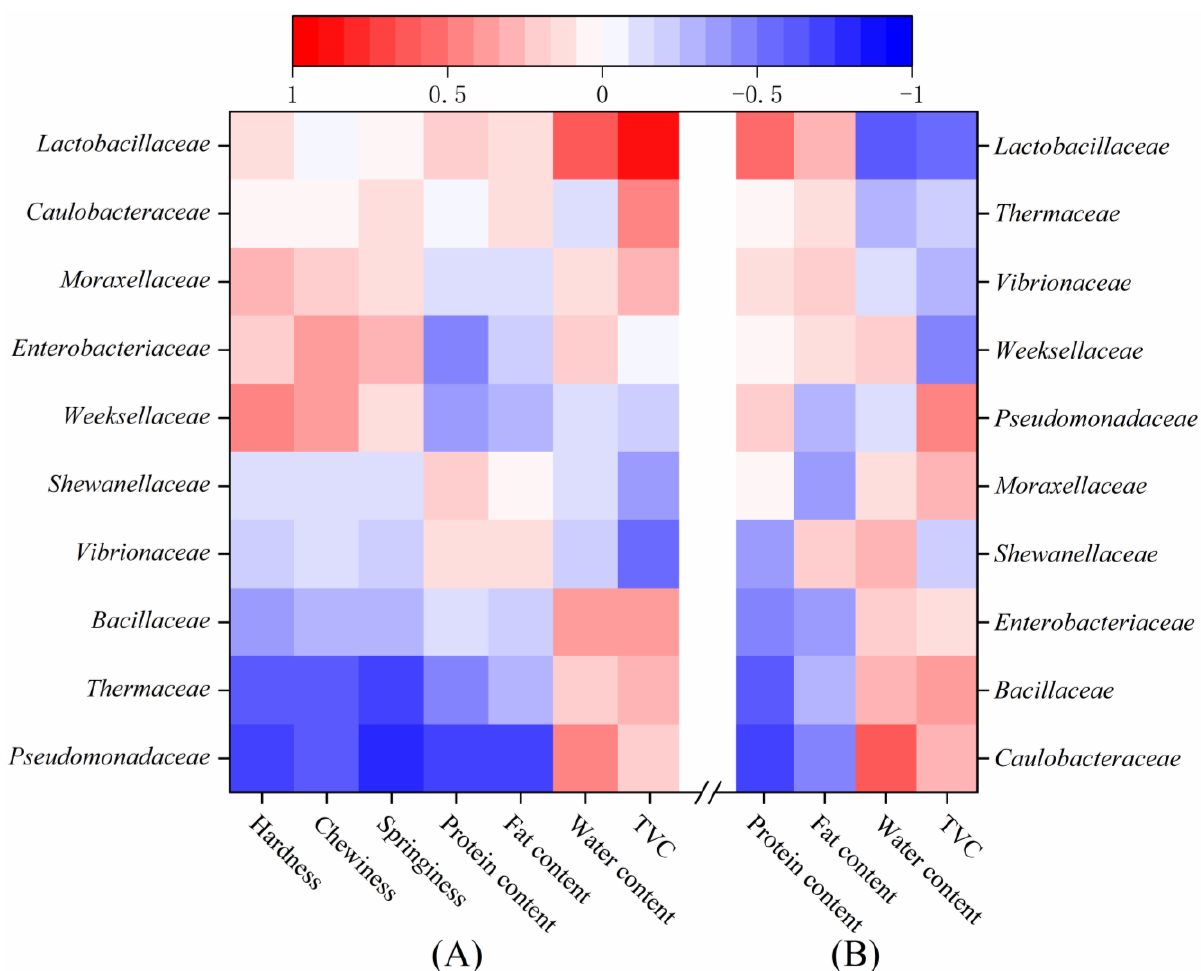
Figure 7. Pearson correlation between the bacterial community family and the quality characteristics of ( A ) LD-tofu and ( B )